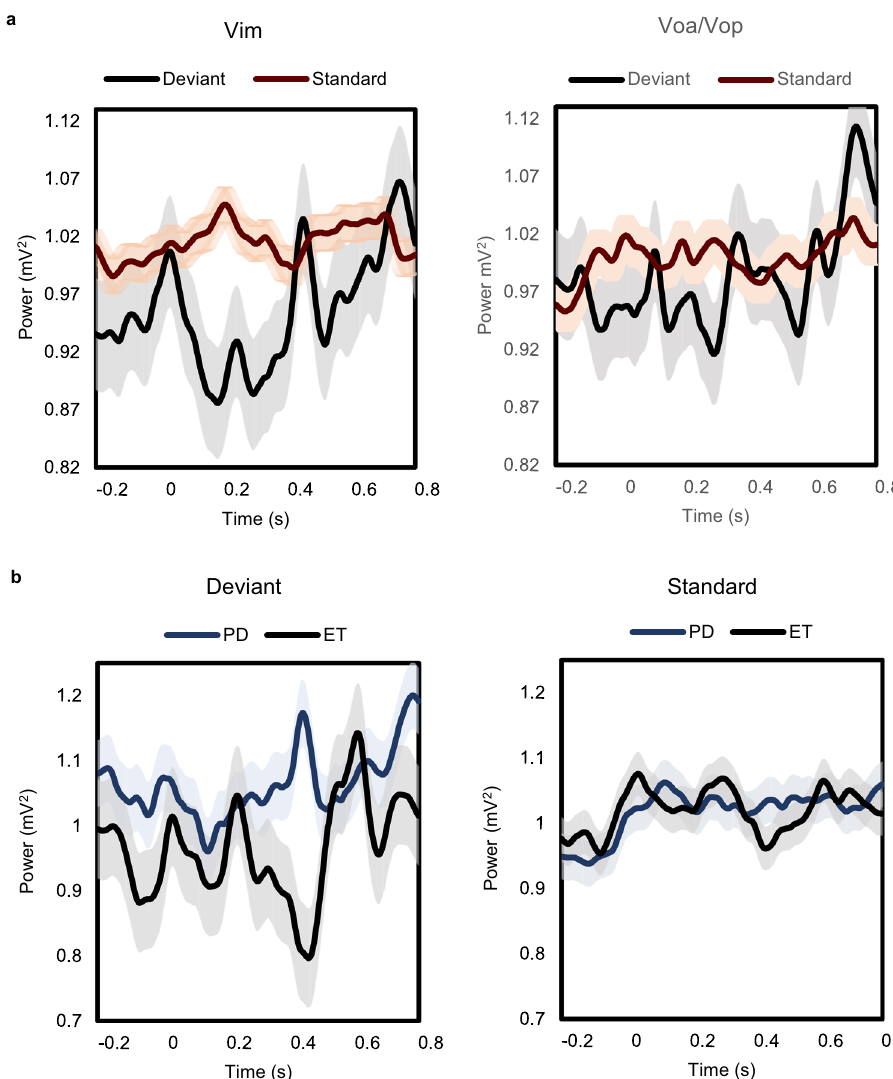
Fig. 5 Averages of beta local fi eld potentials in the motor thalamus and different disease states. a Total averages of beta band (12 – 35 Hz) LFPs in the Vim ( left ) and Voa/Vop ( right ) for the deviant (red) and standard tones (blue). Beta LFPs modulations were observed to the attended tones in the Vim and Voa/Vop. However, a clear modulation is seen in Vim in the cognitive window (0.2 – 0.45 s) to the deviant tones where patients asked to count and not for the standard tones where patients asked to ignore. b beta LFPs divided by the disease type. LFPs in the beta band in response to the deviant tones (left) and the standard tones (right). Blue line is Parkinson ’ s disease tremor ( n = 4), and black line is essential tremor ( n = 15). Clear beta modulations (desynchronizations) are observed in the motor thalamus of ET group but not in the PD patients. These comparisons were signi fi cant in The Mann – Whitney U test. Results are mean ±